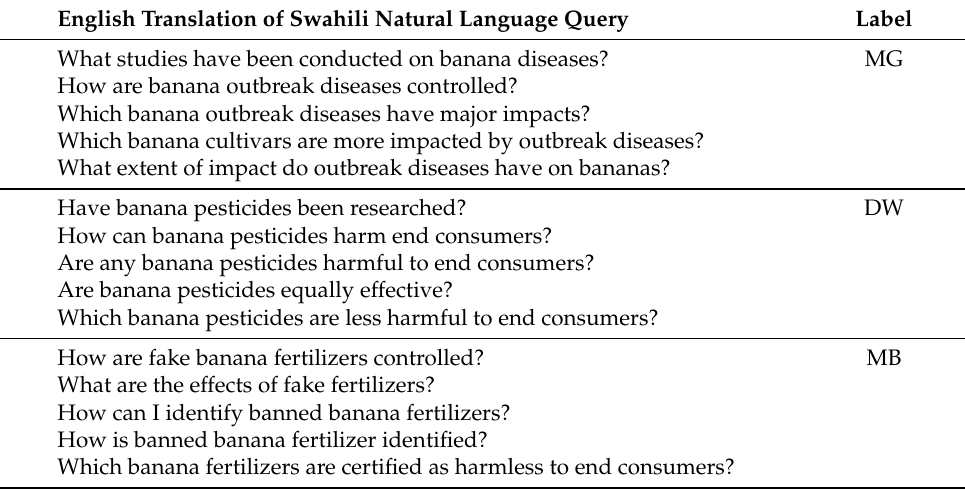
Table 4. Corresponding English translations of Swahili natural language query samples in Table 3. English Translation of Swahili Natural Language Query